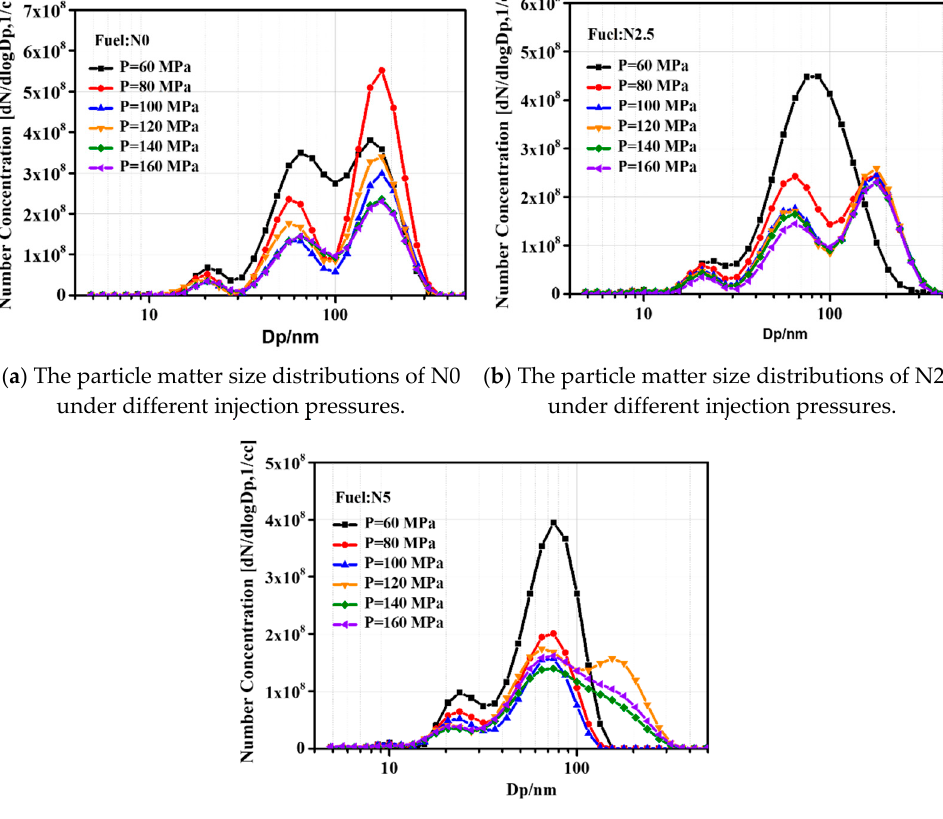
Figure 13. Particle matter size distributions under different injection pressures for n -octanol/diesel blends.